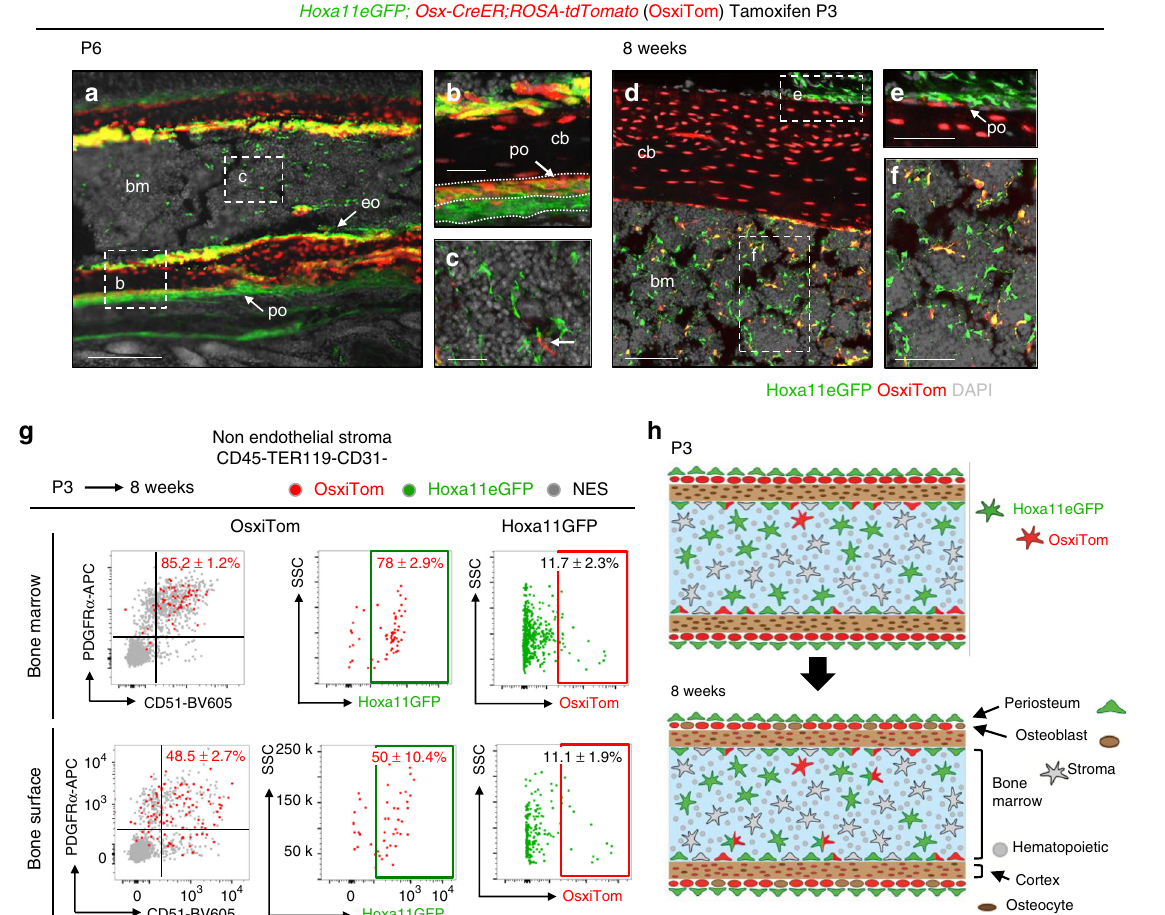
Fig. 9 Postnatal Osx- lineage marginally overlaps with Hoxa11eGFP-positive cells. Comparison of Hoxa11eGFP (green) and Osx-CreER lineage-marked cells (OsxiTom, red) was performed in Hoxa11eGFP;Osx-CreER;ROSA-tdTomato mice. P3 pups received tamoxifen and co-expression of Hoxa11eGFP and postnatal Osx -lineage was examined at ( a – c ) P6 and ( d – f ) 8 weeks. ( a ) Mid-diaphysis ulna; dashed white boxes indicate magni fi ed ( b ) cortical bone and ( c ) bone marrow, rare OsxiTom stromal cell (arrow). ( d ) Mid-diaphysis tibia, white dashed boxes indicate magni fi ed ( e ) periosteum and ( f ) bone marrow. ( g ) Flow cytometry analysis of non-hematopoietic, non-endothelial stroma (CD45-TER119-CD31-) in bone marrow (top panels) and bone surface (bottom panels) compartments. First panel: analysis of OsxiTom population for PDGFR α /CD51, second panel: analysis of OsxiTom for Hoxa11eGFP, third panel: analysis of Hoxa11eGFP-positive cells (green) for OsxiTom expression. ( n = 4). ‘ n ’ represents pooled cells from the radius and ulna of one forelimb of biologically independent animals. Flow cytometry dot plots, gray dots: total non-endothelial stroma (NES). Data presented as mean ± standard deviation. ( h ) Diagrammatic representations of data. Periosteum: po, bone marrow: bm, cortical bone: cb, endosteum: endo All fl uorescent images, gray: DAPI. Scale bars: ( a ) 200 μ m, ( b , c , e , f ) 50 μ m, ( d ) 100 μ